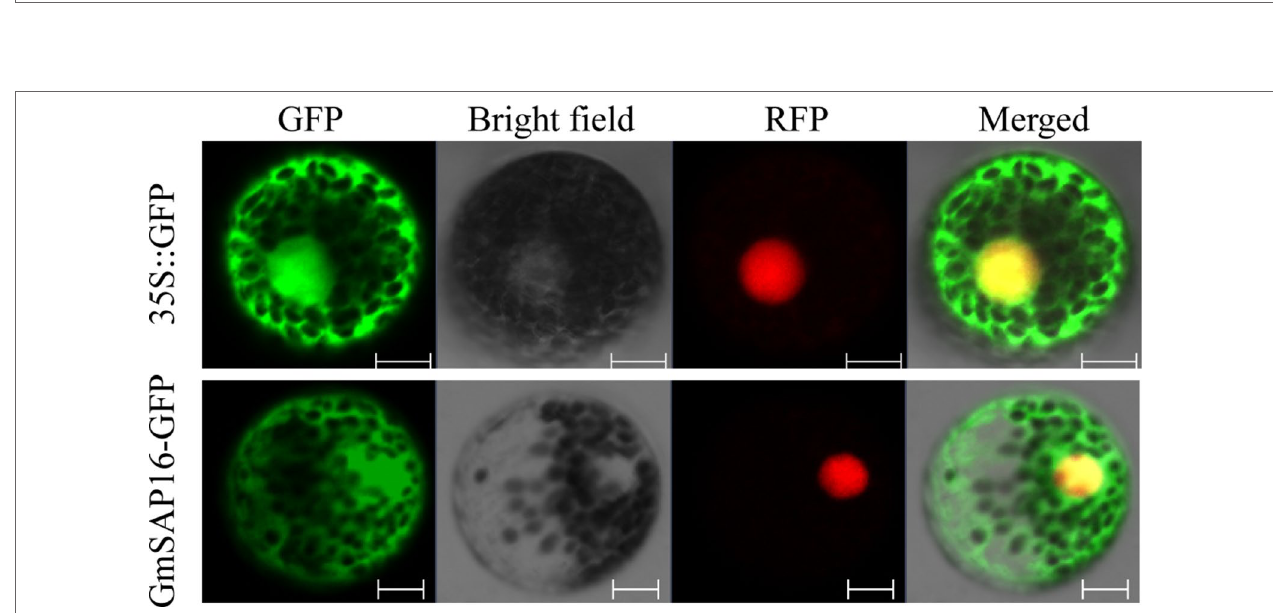
FiGURe 8 | Subcellular localization of GmSAP16. 35S::GFP was used as a control, and nuclear localization signal–red fluorescent protein (NLS-RFP) was used as a nuclear marker. Green and red fluorescence signals were detected by confocal laser scanning. Scale bars = 10 μm.